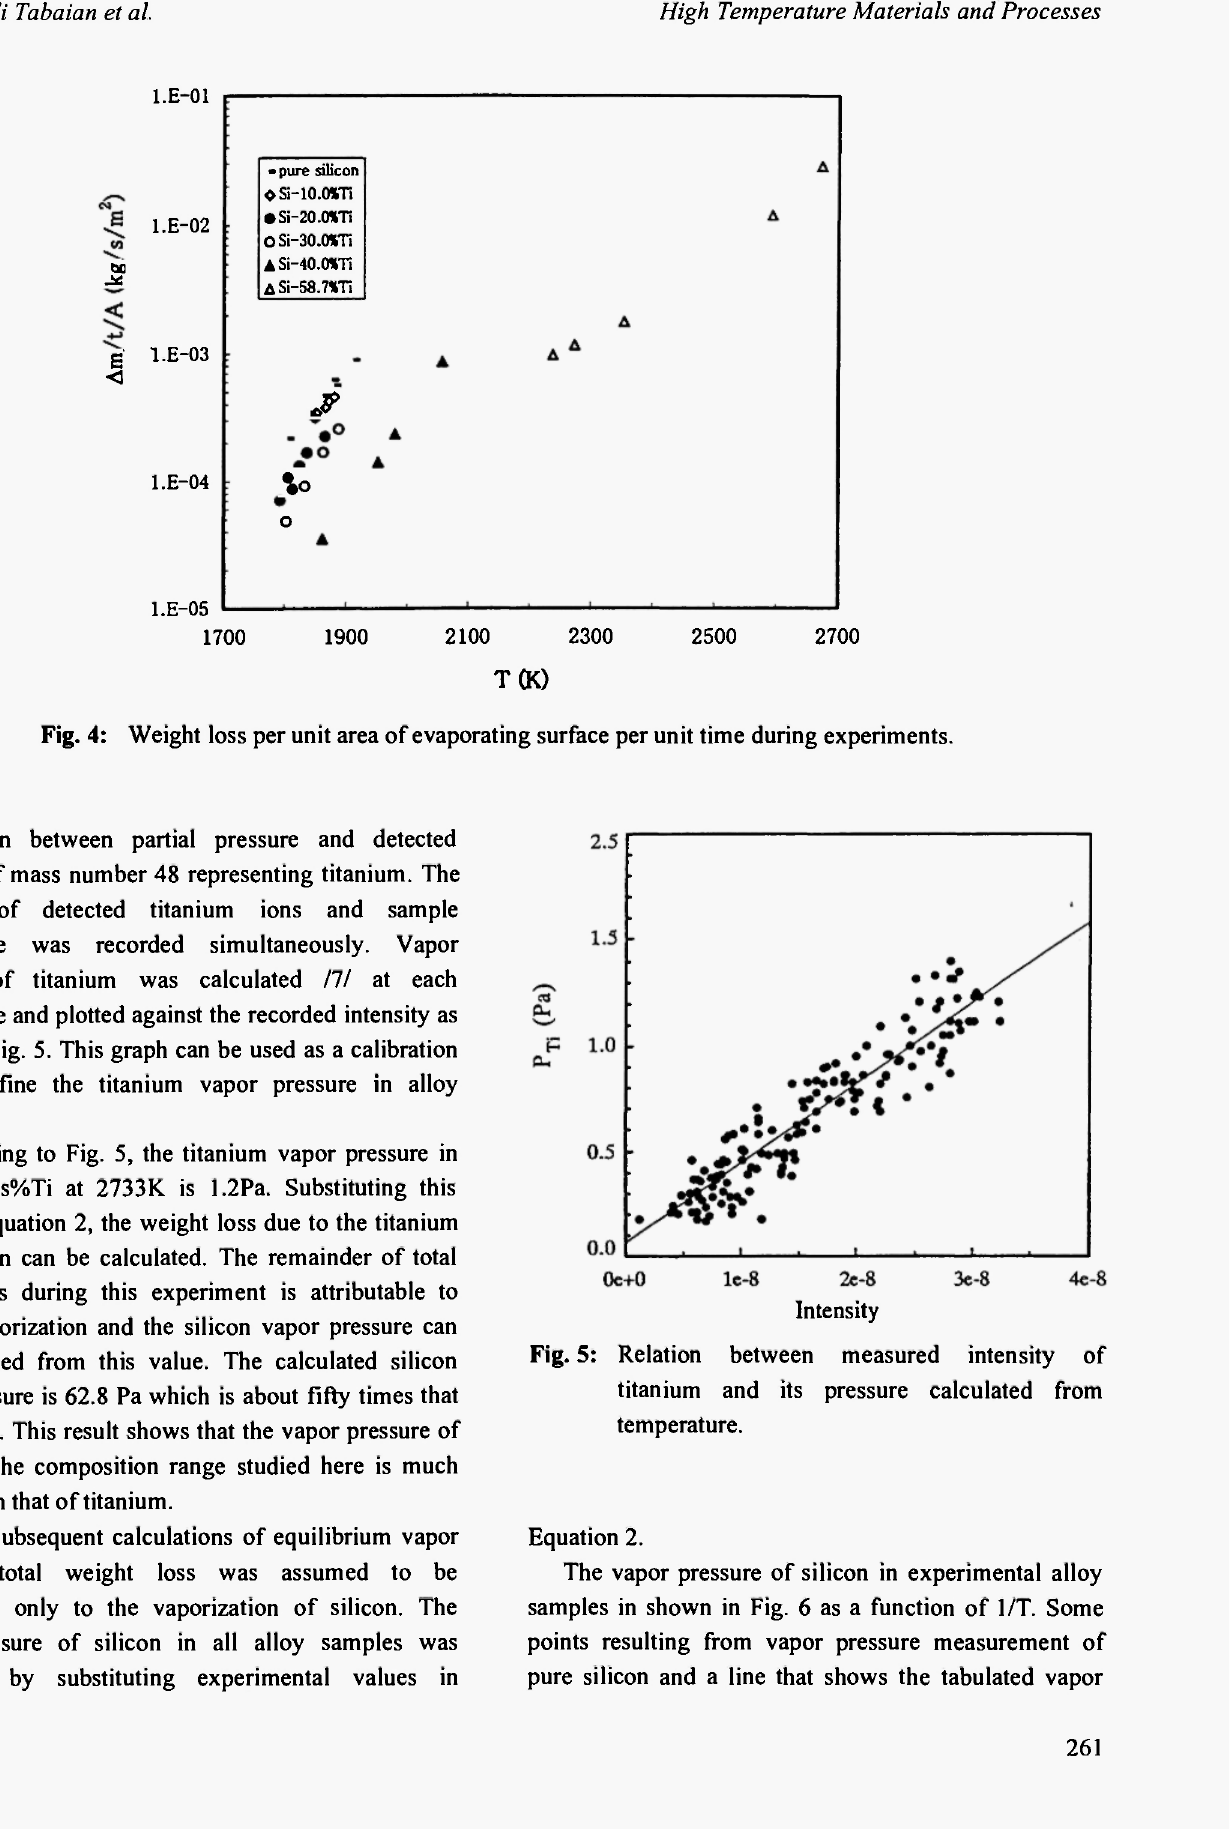
Equation 2. The vapor pressure of silicon in experimental